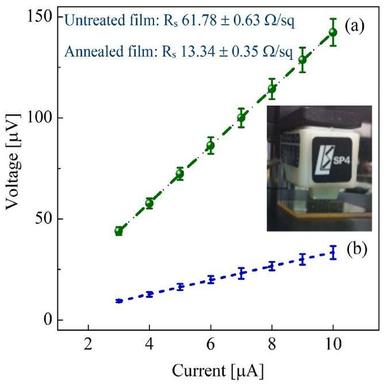
Relationship between the applied current and measured voltage: (a) untreated and (b) annealed films.